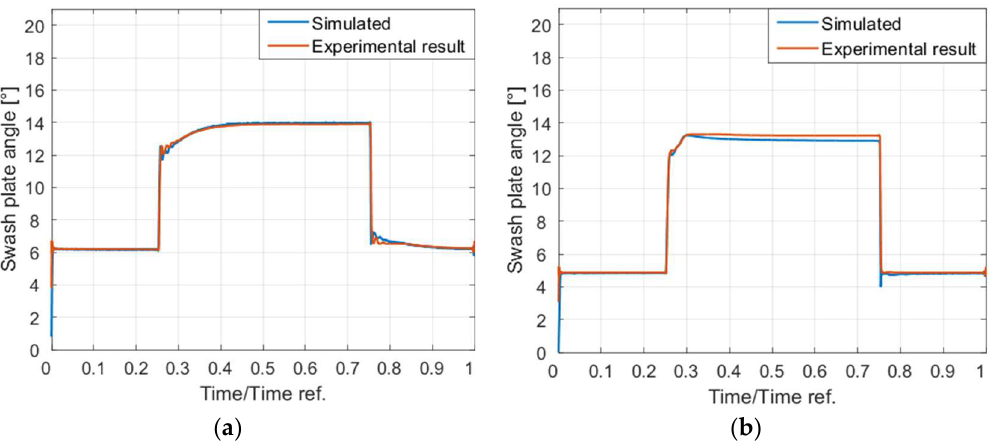
Figure 9. ( a ) Step Test: 1500 r/min, p d = 150 bar, spool opening 23–48%; ( b ) Step Test: 2000 r/min, p d = 50 bar, spool opening 28–47%.